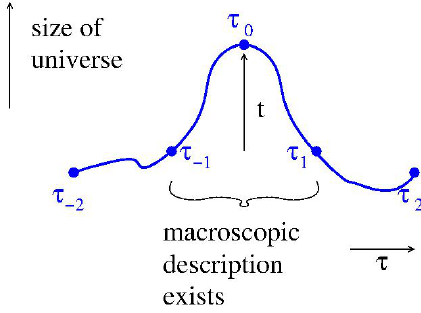
Figure 2. The surjection